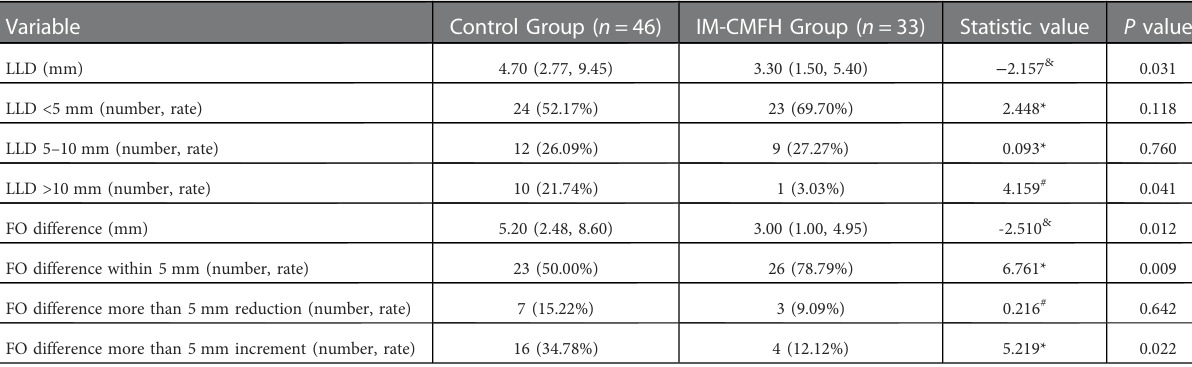
TABLE 2 Postoperative LLD and FO of